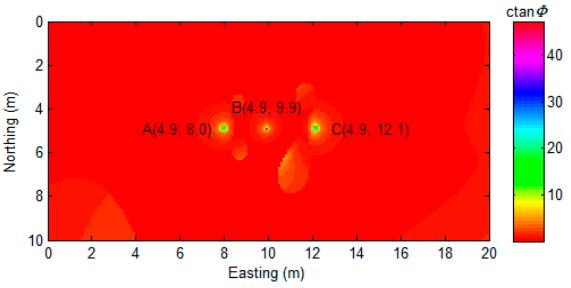
Figure 9. MDTA map. Black text denotes the coordination of detected magnetic dipole locations. ( α = 0).